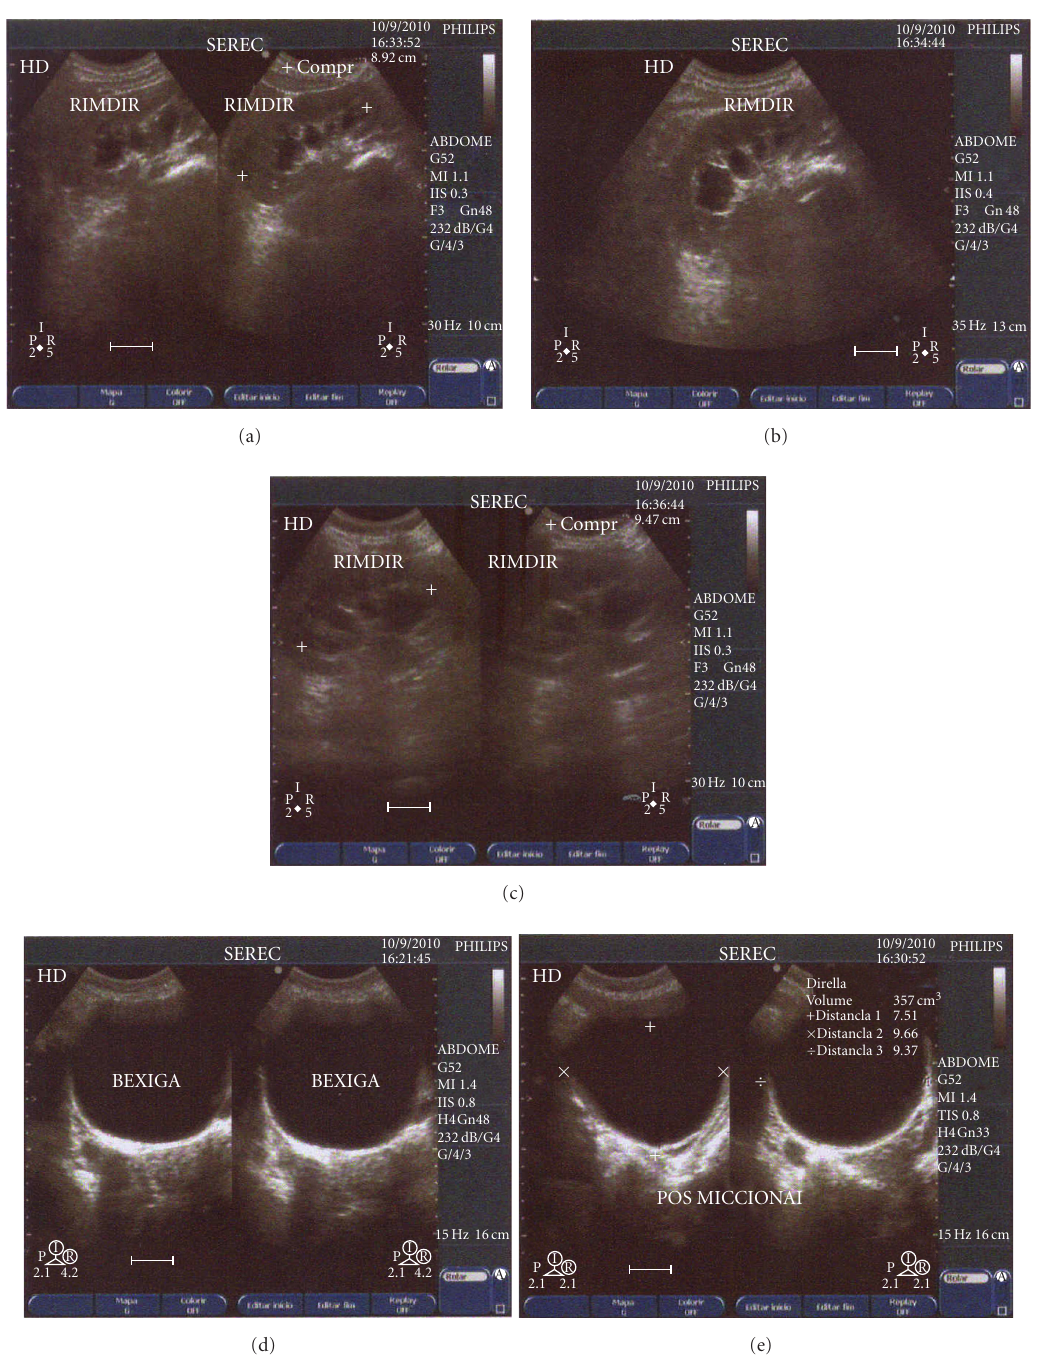
Figure 3: Urinary sonogram performed on patient (2010) revealing grade II hydronephrosis consistent with noncontractile